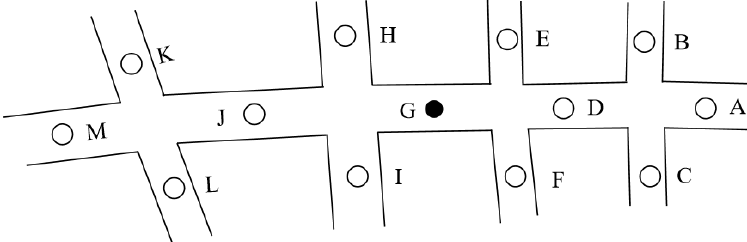
Figure 4. Diagram of the location of the observation point.